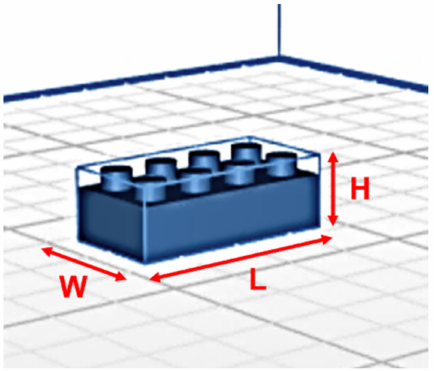
Figure 1. CAD model of the reproduced Lego-type brick (W—width, L—length,